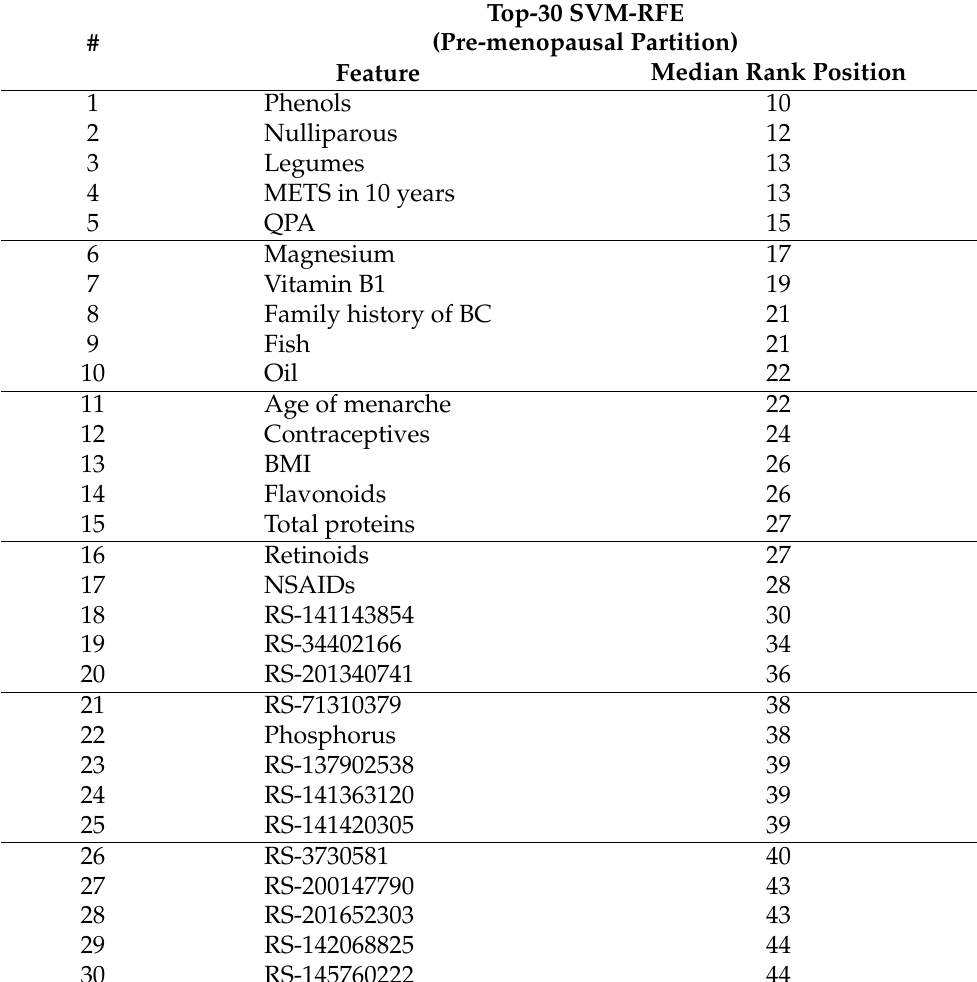
Table 13. Top-30 features of SVM-RFE ranking for pre-menopausal data partition.